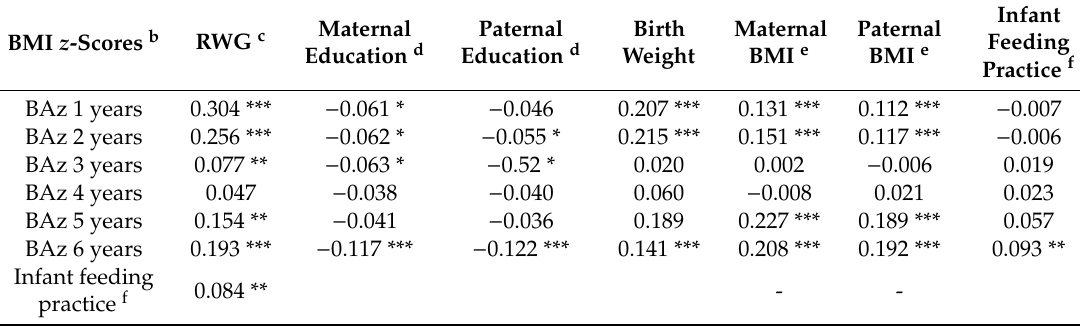
Table 2. Bivariate correlations among rapid weight gain, infant feeding practices, and BAz in children from the CALINA a